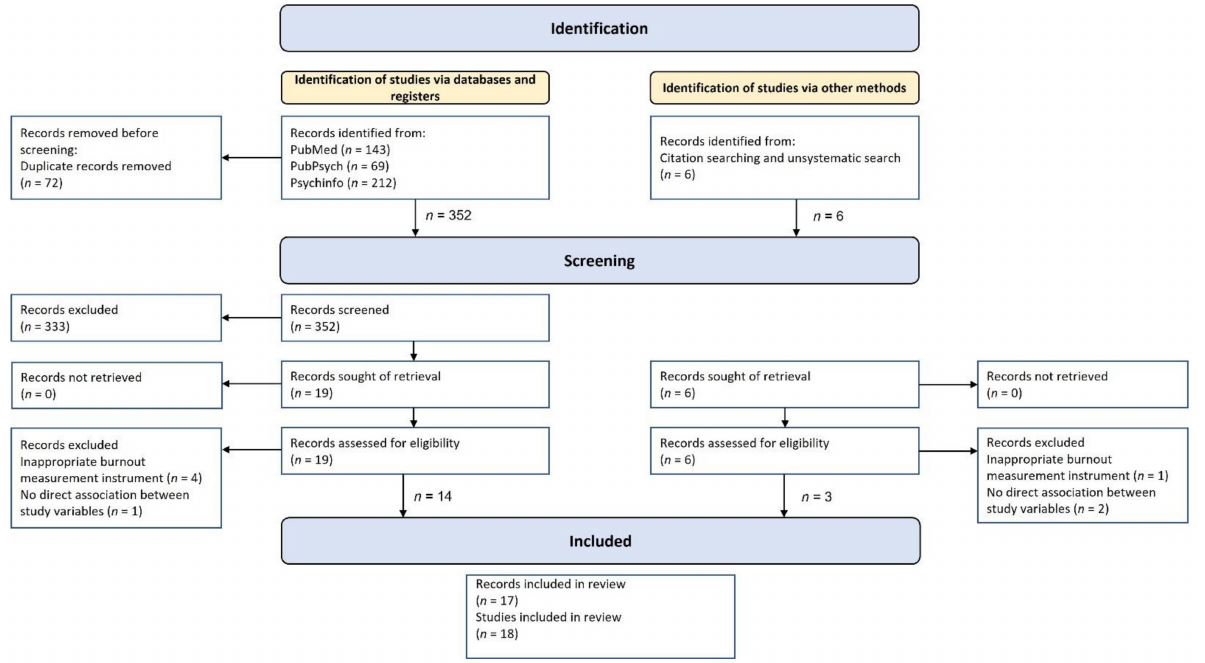
Figure 2. Selection process for the systematic review (adapted from the PRISMA guidelines; Page et al.,